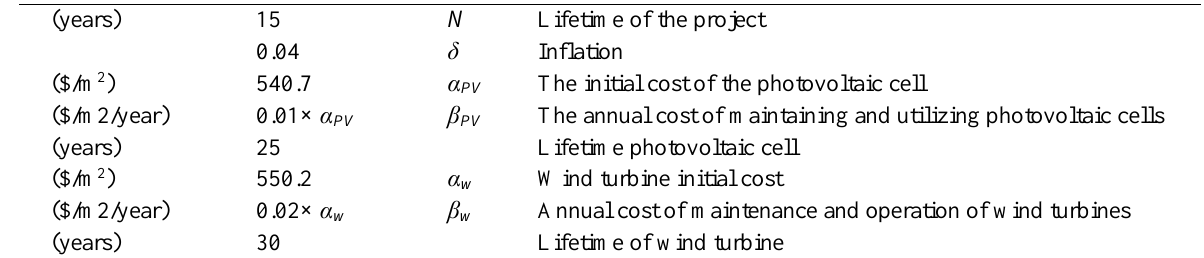
Table 1. The Used